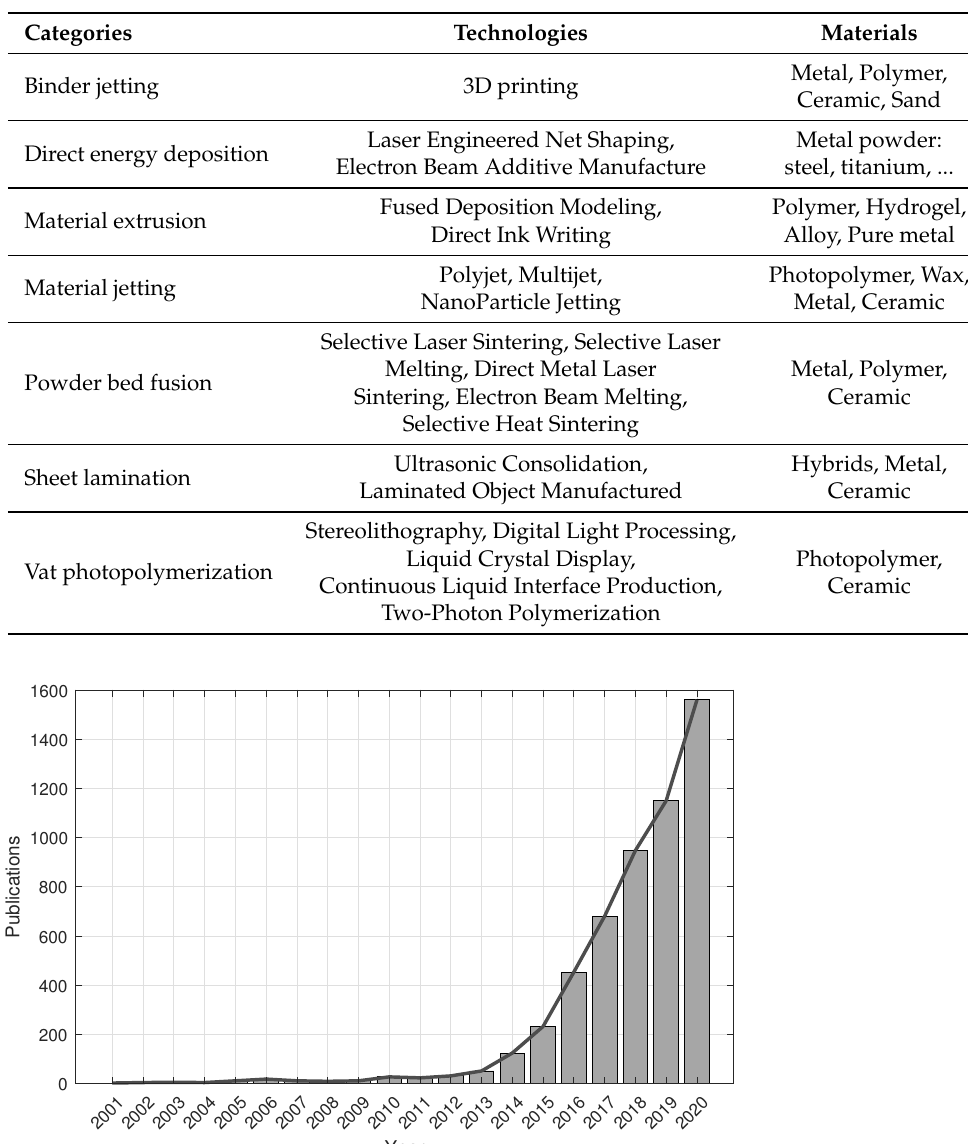
Table 1. Classification of 3D printing technologies according to the ASTM [17].